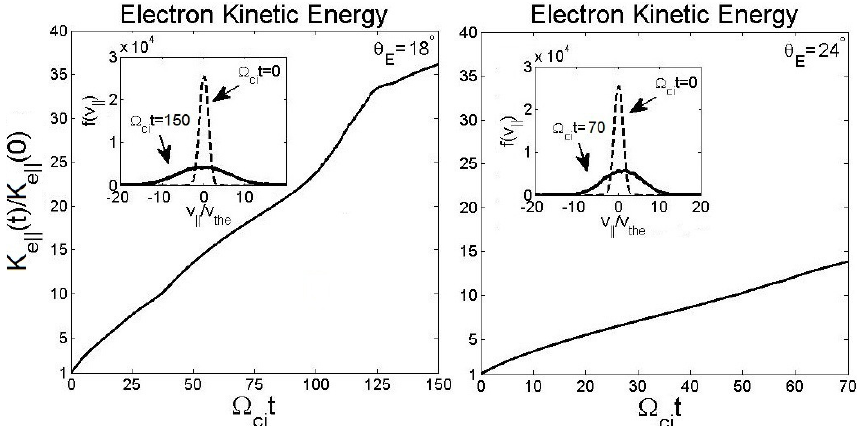
Fig. 5. Time evolution of parallel electron kinetic energy and corresponding electron velocity distribution functions at the end of the simula- tion for θ E = 18 ◦ and θ E = 24 ◦